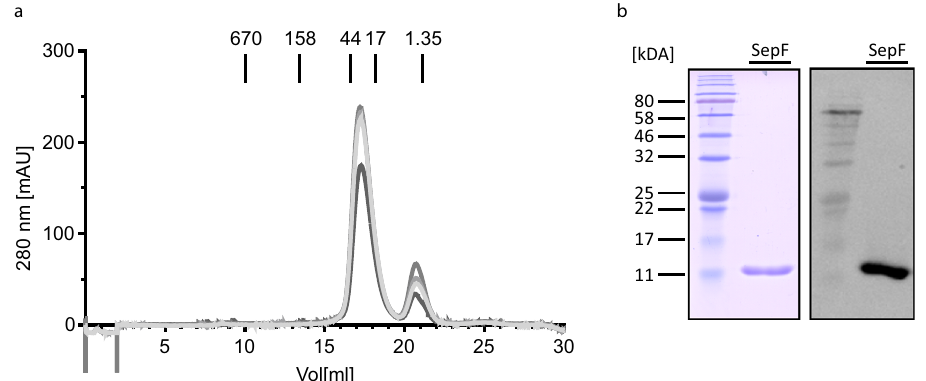
Fig. 9 Size exclusion chromatography with SepF. a Puri fi ed SepF was loaded on a Superdex 200 10/300 GL column. Absorption at 280 nm at the different elution volumes for four independent experiments are shown. Elution volumes of protein size markers are indicated in kDA. b SDS-gel and Western blot with anti-His antibodies of SepF after SEC. Elution fractions of two of the four repetitions were loaded on an SDS-gel (see Supplementary Fig.